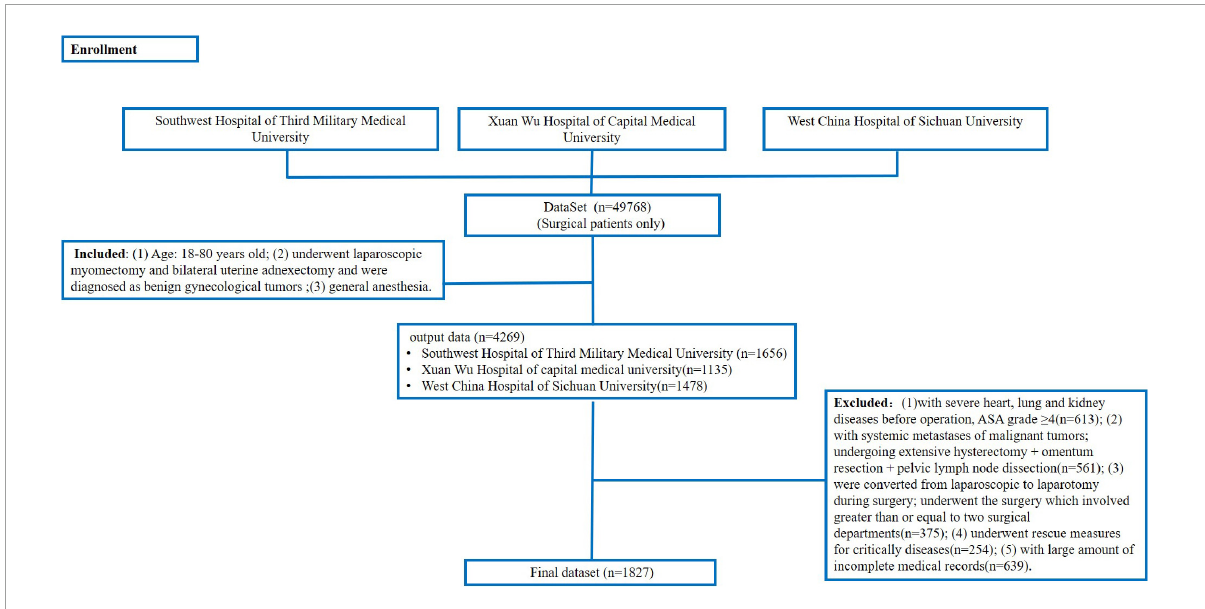
FIGURE4 The process of